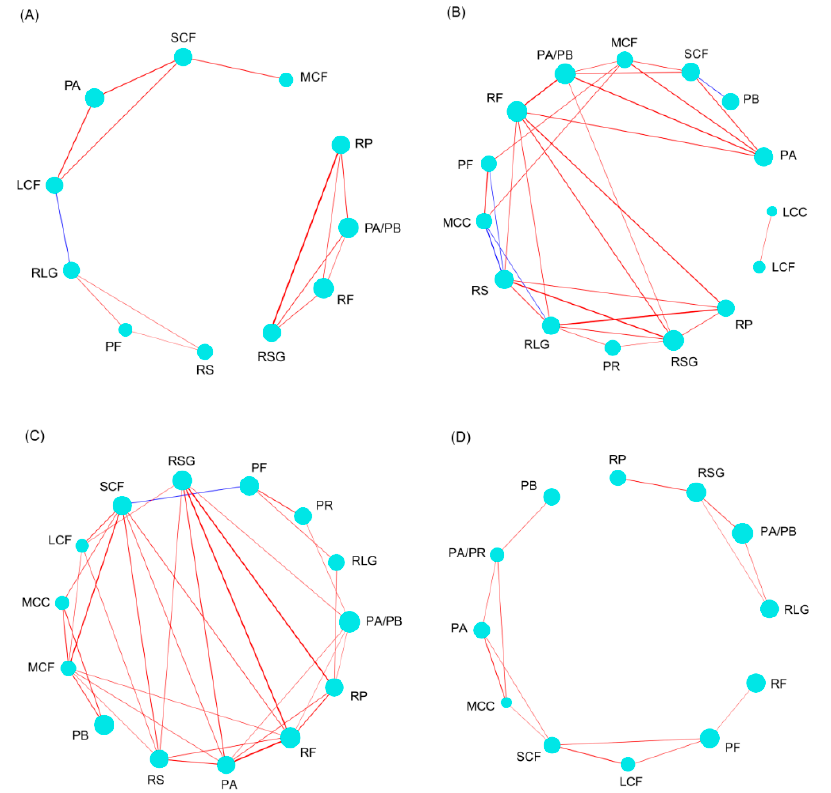
Figure 6. Co-occurrence networks of zooplankton functional groups. ( A ) spring, ( B ) summer, ( C ) autumn, and ( D ) winter. The red and blue edges indicate significant positive and negative correlations, respectively. The edge wide indicates the correlation coefficient.